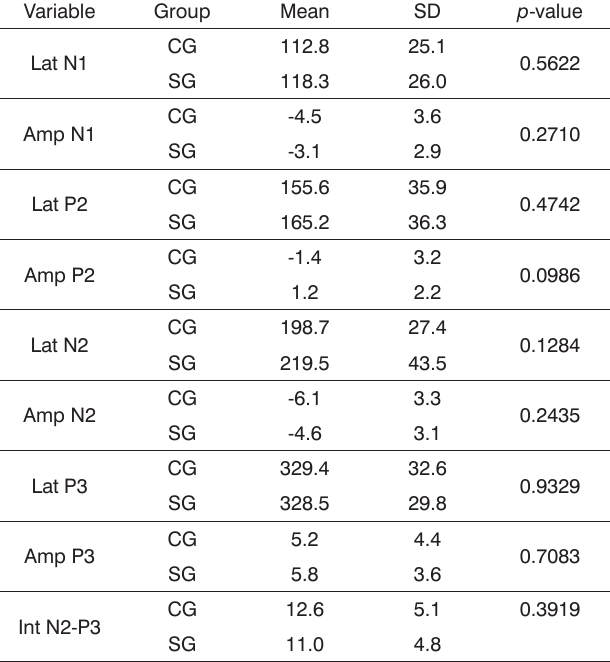
Table 4. Descriptive statistics of the mean, standard deviation (SD) and p -value of the N1, P2, N2 and P3 latency and am- plitude variables and P300d N2-P3 inter-amplitude for the LE.